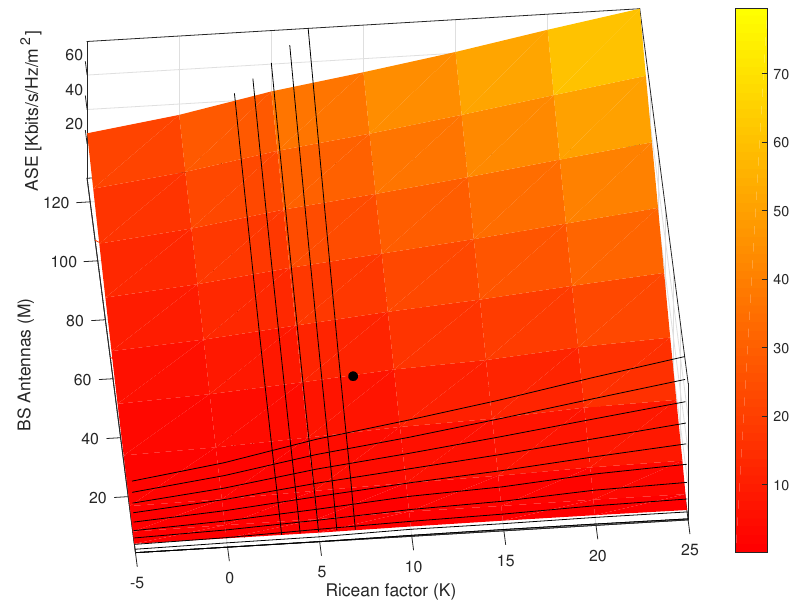
Figure 10. Plot of the ASE with the BS antenna ( M ) and Ricean factor